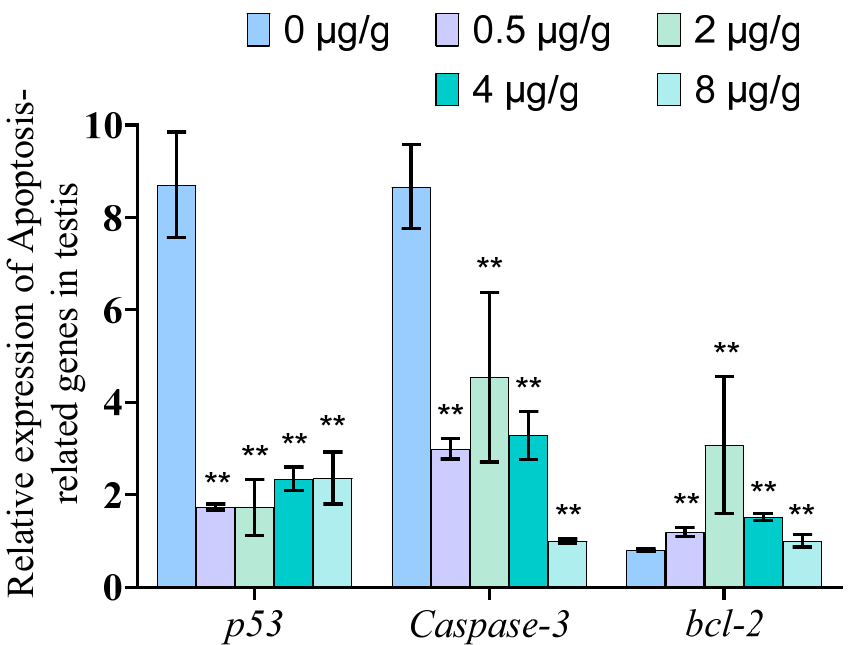
Figure 6. Apoptosis-related genes expression. The expression of p53 and Caspase-3 mRNA in the testis decreases significantly and bcl-2 mRNA increases significantly after SOV injection (** indicates significant compared with control group Significance. **: p <